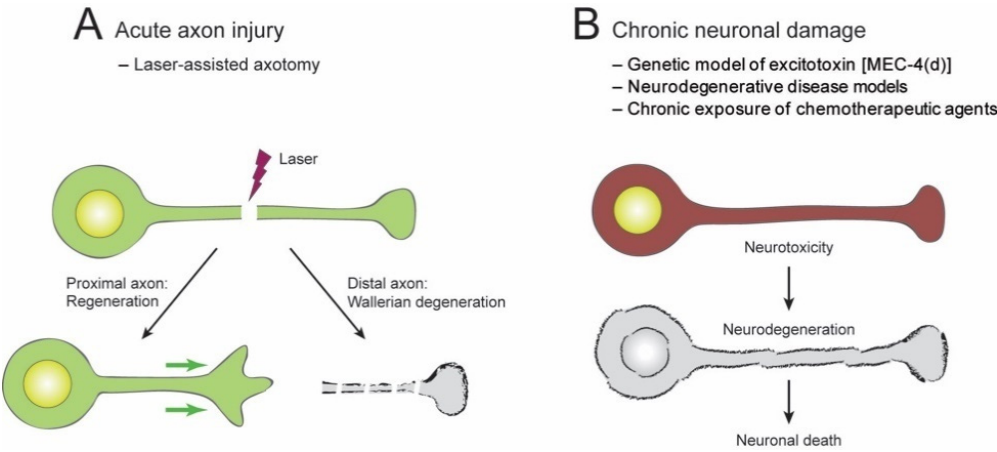
Figure 3. C. elegans models of neuronal damage. ( A ) Acute axon injury by laser-assisted axotomy. ( B ) Chronic neuronal damage models.